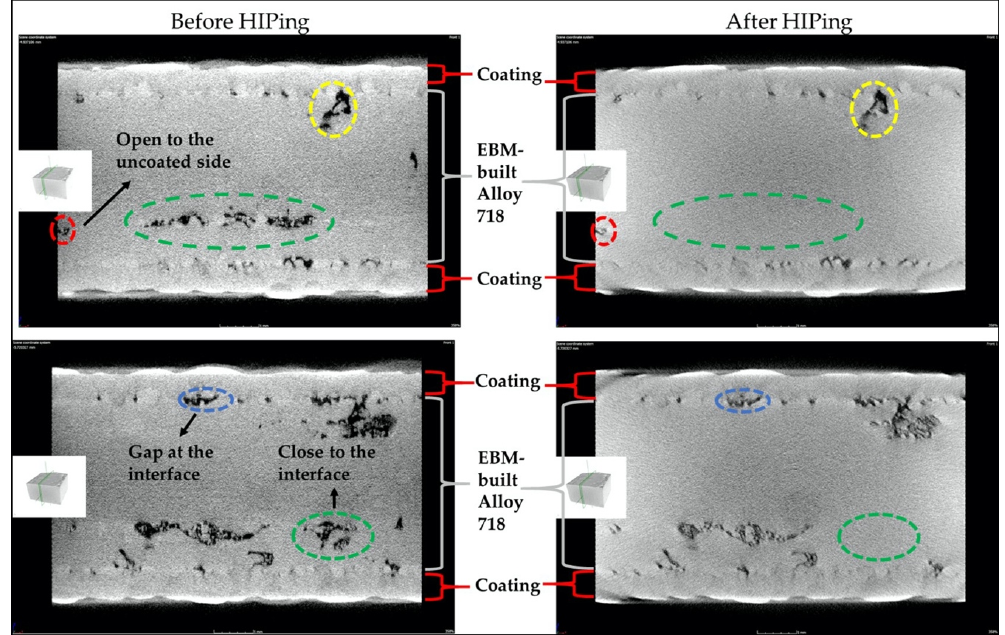
Figure 8. Two-dimensional ( 2D) sliced images from XCT analysis showing the “tracked” defects at the same cross-sections in the entire coated sample before and after HIPing. same cross-sections in the entire coated sample before and after